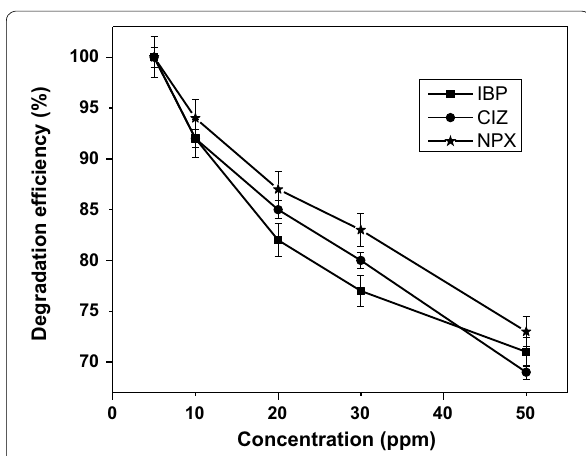
Fig. 3 Effect of the initial drugs concentration on the degradation efficiency under UV-light irradiation at pH 2, drug solution volume of 100 mL, and irradiation time of IBP CIZ 25 min =